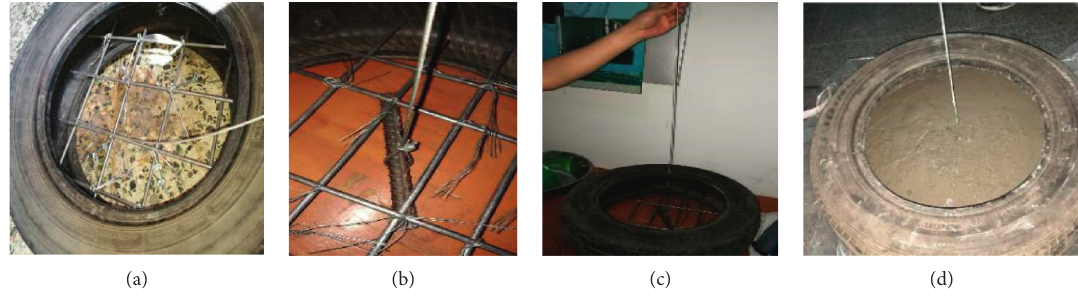
Figure 6: The concrete structure construction step of back cover.